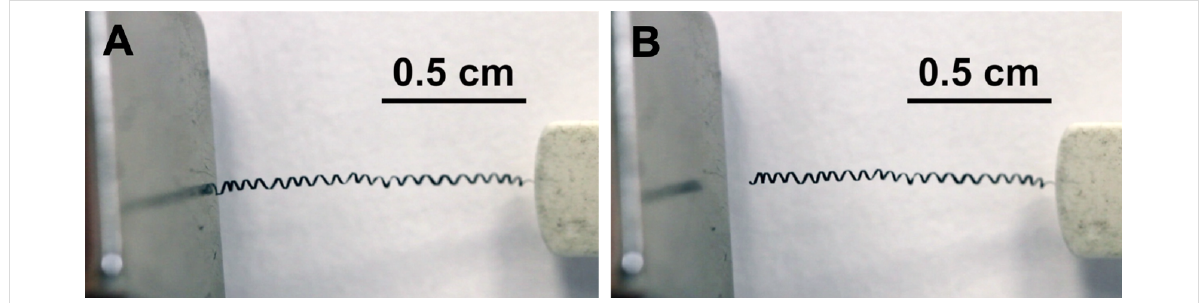
Figure 5: Freeze frames from a video showing attraction to and reversible stretching of a helical fiber by a permanent neodymium magnet (see Sup- porting Information File 2 for the full video).